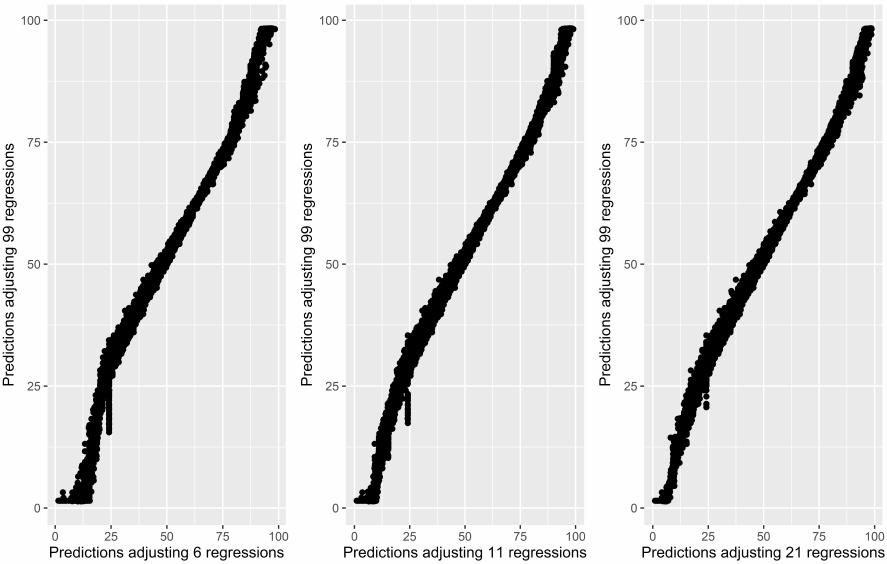
Figure 2. Risk scores when 99 quantile regressions are used in the first step are compared to risk scores when quantile approximations are used in the first step with m = six initial regressions ( left ), m = 11 ( center ) and m = 21 ( right ).